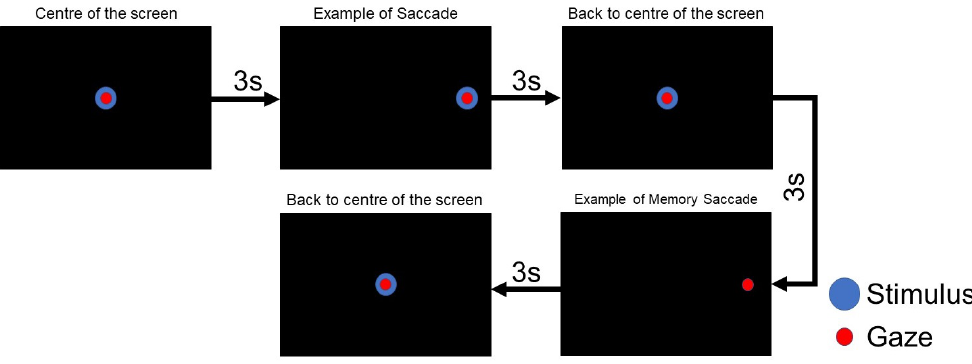
Figure 5. Horizontal memory guided saccade